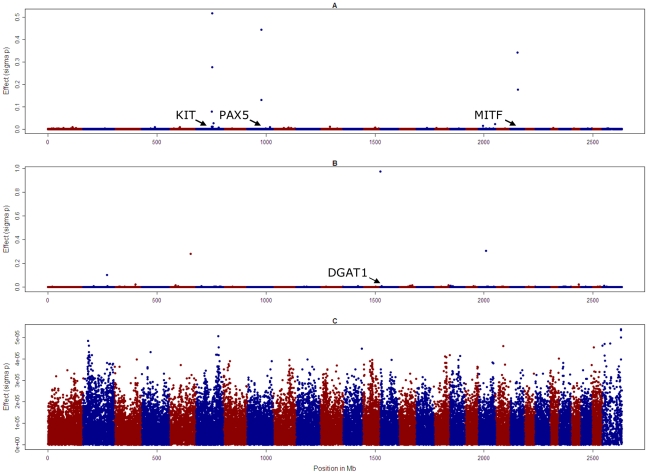
Genome-wide SNP effects when all SNPs are fitted simultaneously for three traits in Holstein Friesian cattle.Proportion of black (A), fat% (B), and overall type (C). Note the different scale of the y axis for overall type compared with proportion of black and fat%.